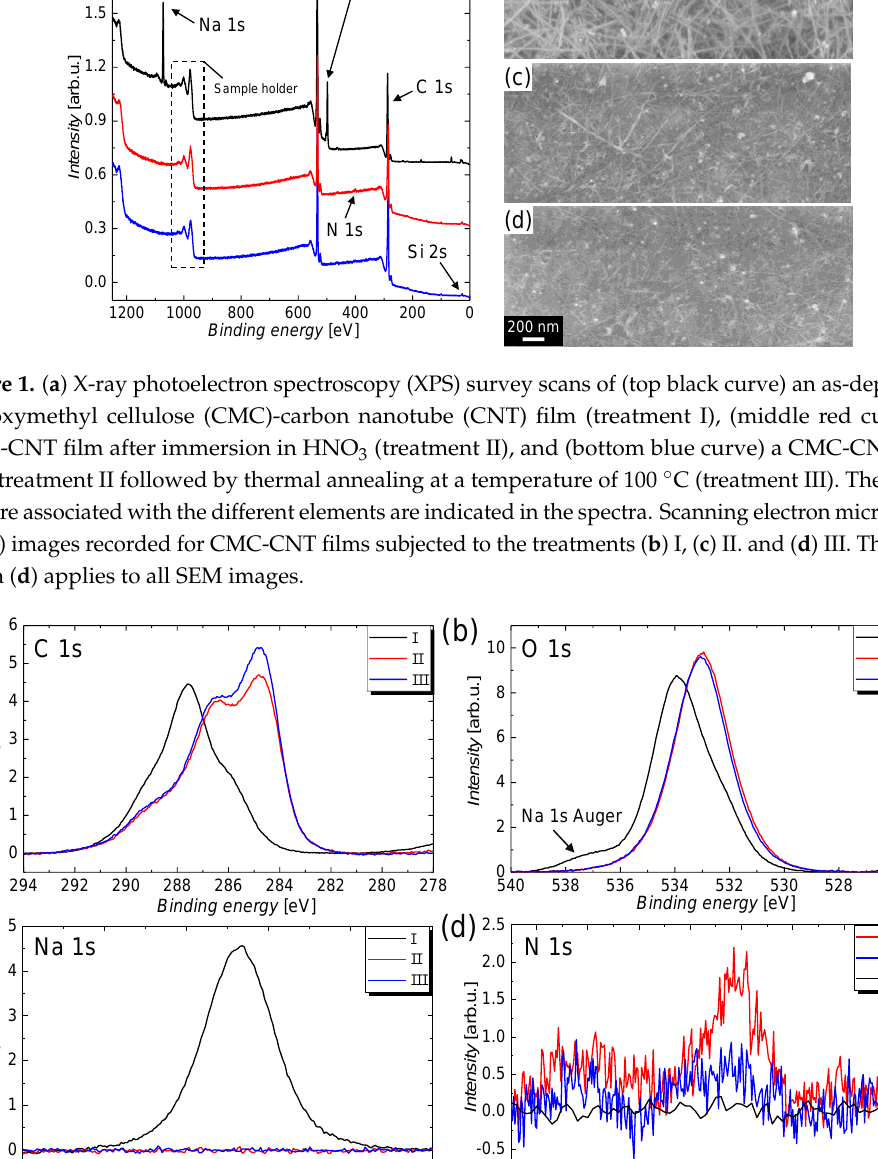
294 292 290 288 286 284 282 280